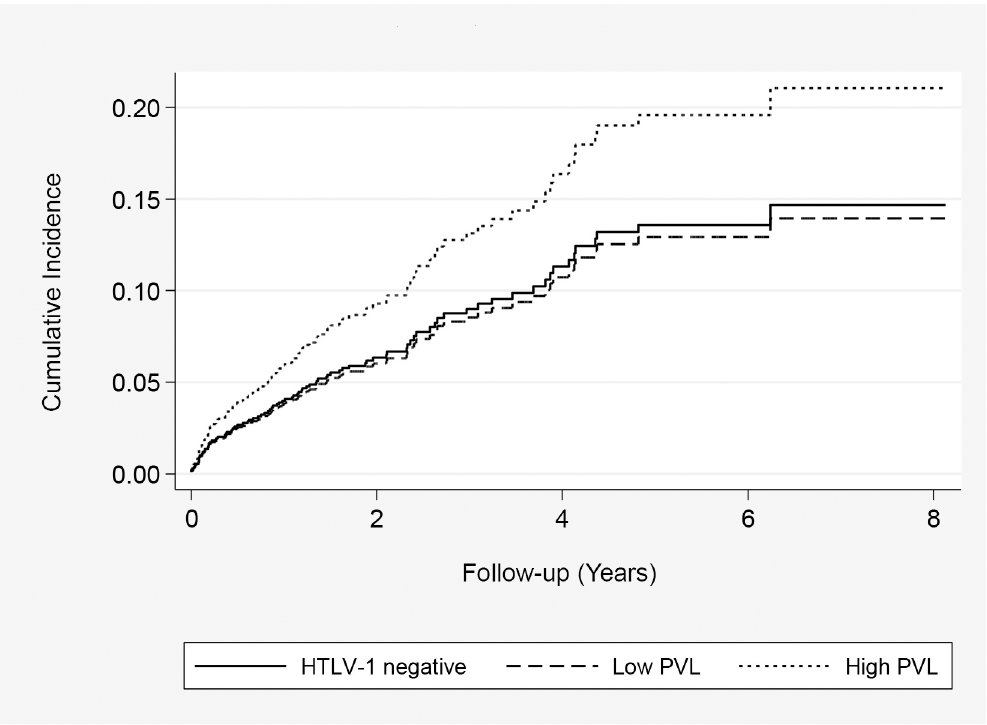
Fig 4. Cumulative death rate due to bronchiectasis. Estimated using competing-risks Cox regression among 533 HTLV-1 uninfected subjects, 212 subjects with low HTLV-1 proviral load ( < 1000 copies/10 5 peripheral blood leukocytes) and 95 with high HTLV-1c proviral load ( (cid:21) 1000 copies/10 5 peripheral blood leukocytes).